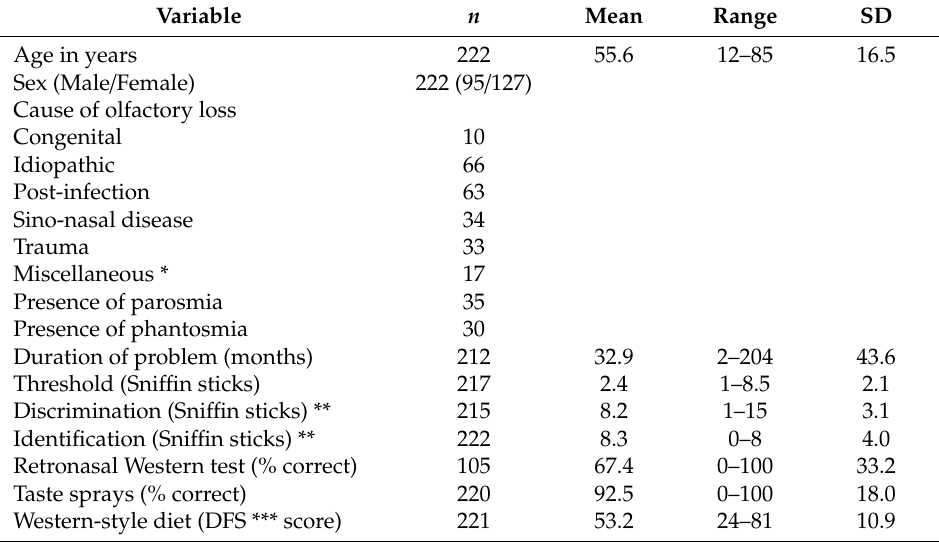
Table 1. Descriptive statistics of the case series.